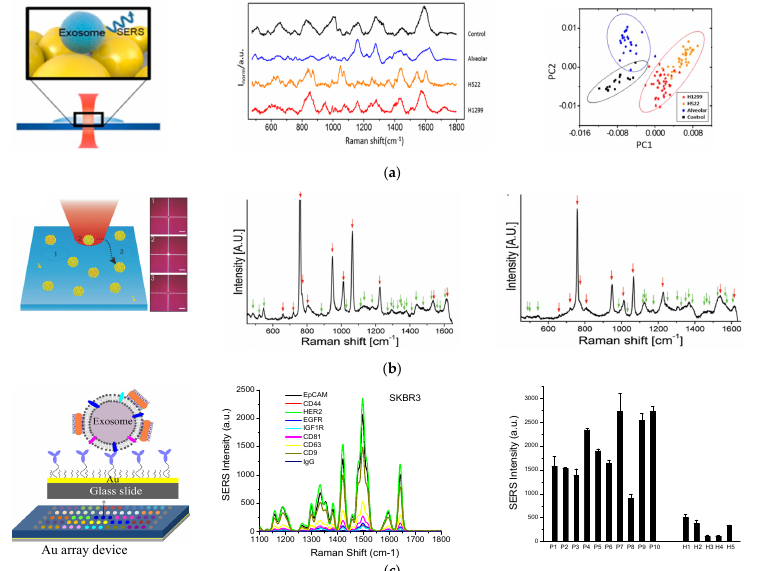
Figure 4. SERS − based molecular detection of exosomes. ( a ) Exosome classification through SERS detection of exosomes from normal and lung cancer cells. Left: Schematic of SERS detection of exosomes. Middle: SERS spectra of exosomes from different origins and control using PBS. Right: Principle component scatter plot showing clusters of exosomes from different origins. Reprinted with permission from [71]. Copyright (2017) American Chemical Society. ( b ) Individual molecular detection of exosome-like vesicles by label-free SERS spectroscopy. Left: Schematic of single EV detection. Each spectrum was recorded from one vesicle to another by moving the laser to a different spatial location of 1, 2, 3, etc. Middle: Representative SERS spectrum of EVs derived from B16F10 melanoma cells. Right: Representative SERS spectrum of EVs derived from red blood cells. Reprinted with permission from [75]. Copyright 2016 WILEY-VCH Verlag GmbH & Co. KGaA, Weinheim. ( c ) Molecular detection and analysis of exosomes with SERS AuNRs. Left: Schematic of the detection principle showing exosome capture with target-specific antibodies on an Au array device and exosome detection with SERS AuNRs via electrostatic interactions with exosome membranes. Middle: Detection of different surface protein markers on exosomes derived from SKBR3 breast cancer cells. Right: Detection of HER2-breast cancer by quantification of HER2-positive plasma exosomes. Cited from ref. [34].